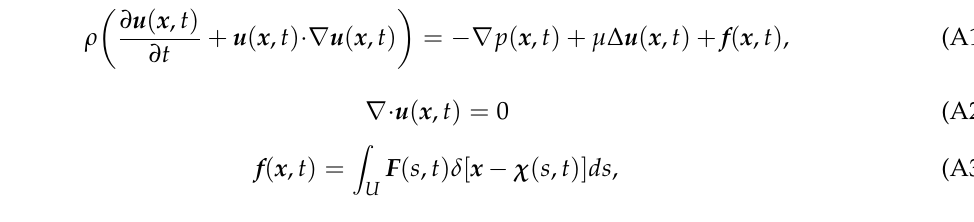
Figure S1: Spanwise flow above the wing at mid-stroke (aoa = 45 ◦ , Re range from 4–128). Figure S2: Vector fields and spanwise flow at mid-stroke ( Re = 32, aoa range from 0 ◦ to 90 ◦